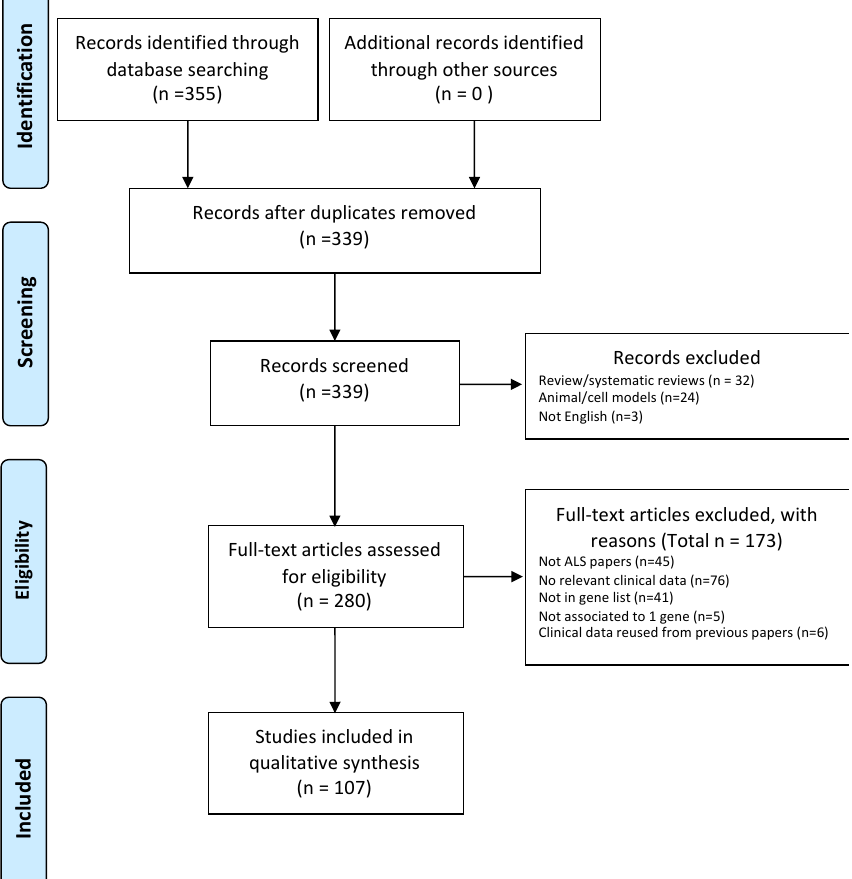
Figure 3. PRISMA flow chart showing how studies have been selected.